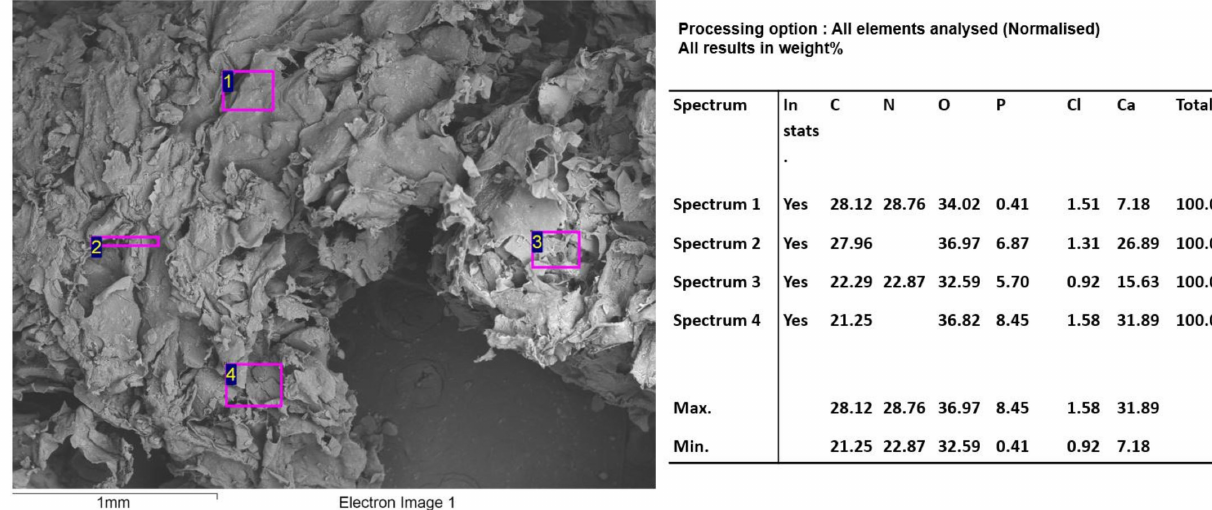
Figure 9. F2 (InterOss Collagen) SEM/EDS